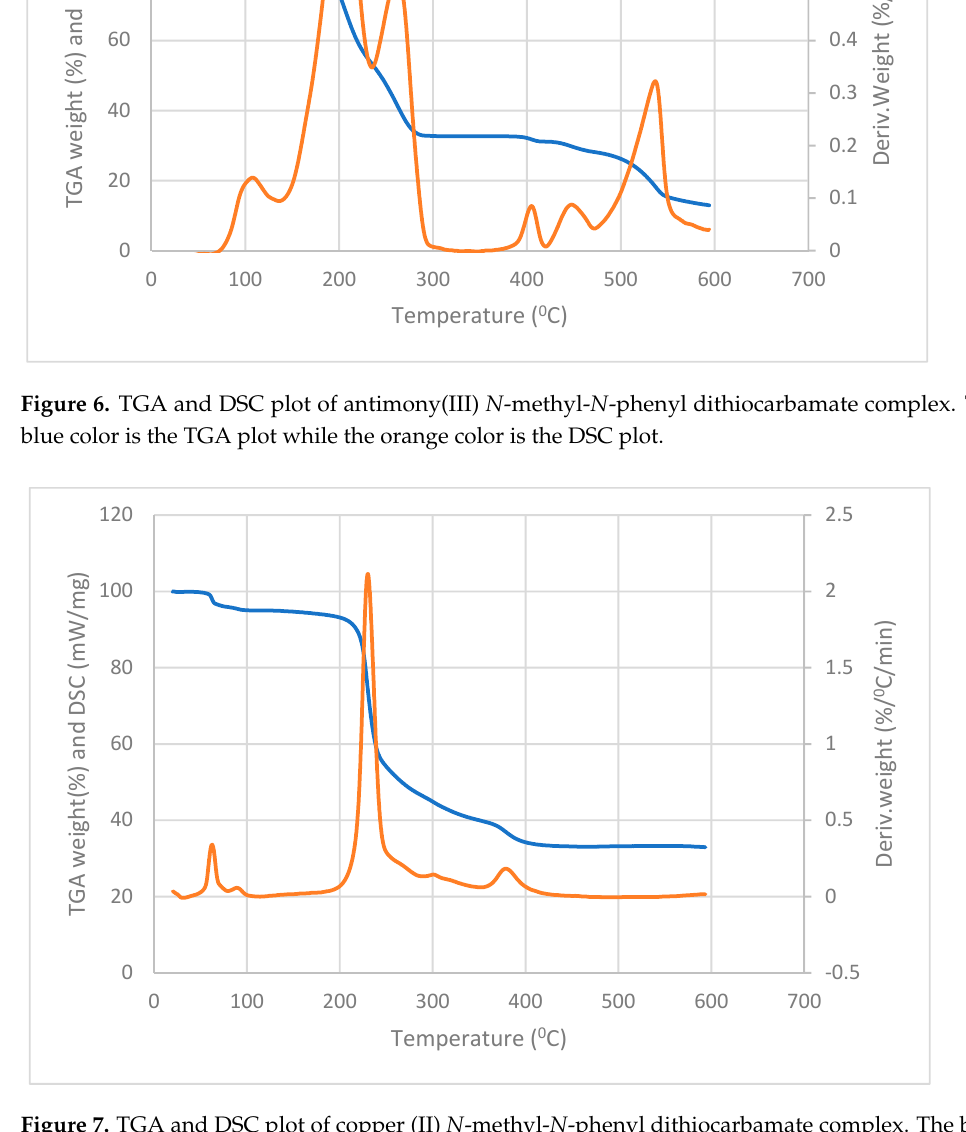
Figure 8. TGA and DSC plot of indium (III) N -methyl- N -phenyl dithiocarbamate complex. The blue color is the TGA plot while the orange color is the DSC plot. 3.3. Effects of Inorganic Dithiocarbamate Complexes on TZM-bl Cells The cytotoxicity of five compounds of dithiocarbamate complexes, Ag(I)DT, Cu(II)DT, Bi(III)DT, In(III)DT, and Sb(III)DT, was assessed in TZM-bl cells to determine their safety. The effect of the compounds on TZM-bl cells was measured as percentage cell viability and was compared with the TDF positive control (Figure 9). Overall, the assays showed a decreasing order of cell viability of Cu(II)DT < Ag(I)DT < In(III)DT < Sb(III)DT < BI(III)DT < TDF. The cytotoxicity examined with the MTT assay showed that all the test compounds were non-toxic when used at concentrations of 0.002–1.23 μ g/mL, with 80– 130% cell viability. The increase in the percentage cell viability above 100% is suggestive of an active cell proliferation during the period of the experiment [47]. However, as the concentration increased (11 μ g/mL), the viability of cells treated with Ag(I)DT and